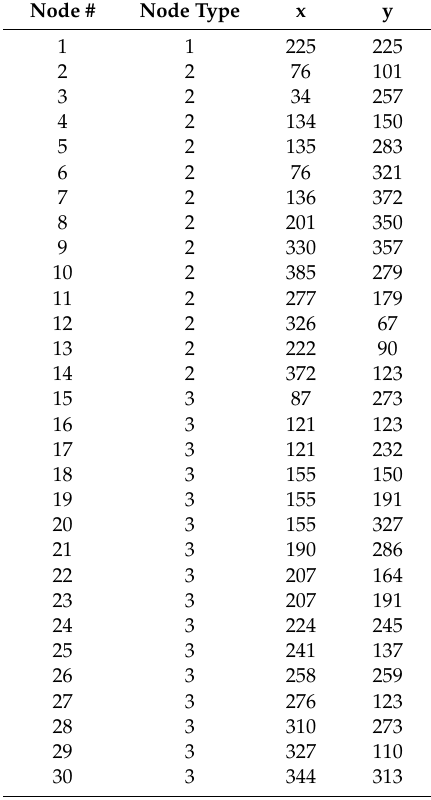
Figure3. Casestudy1: ( a )Initiallayout; ( b )synthesizednetworkusingtheCADtool; and( c )synthesized network using the proposed approach. Table 1. Nodes of the synthesized network using the proposed approach for case study